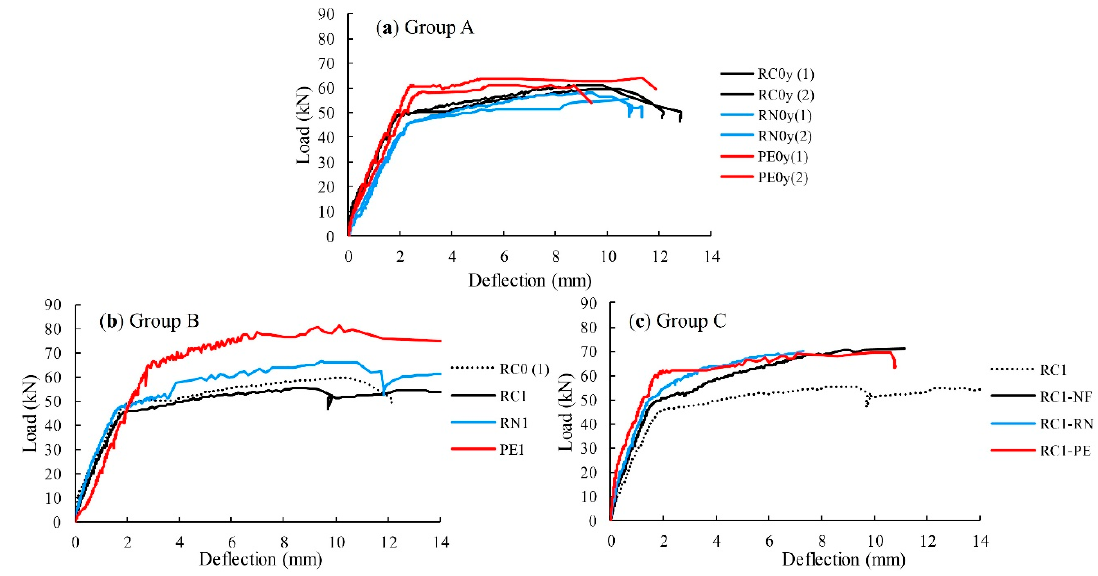
Figure 6. Load-midspan deflection curves of RC beams: ( a ) Group A; ( b ) Group B; and ( c ) Group C.